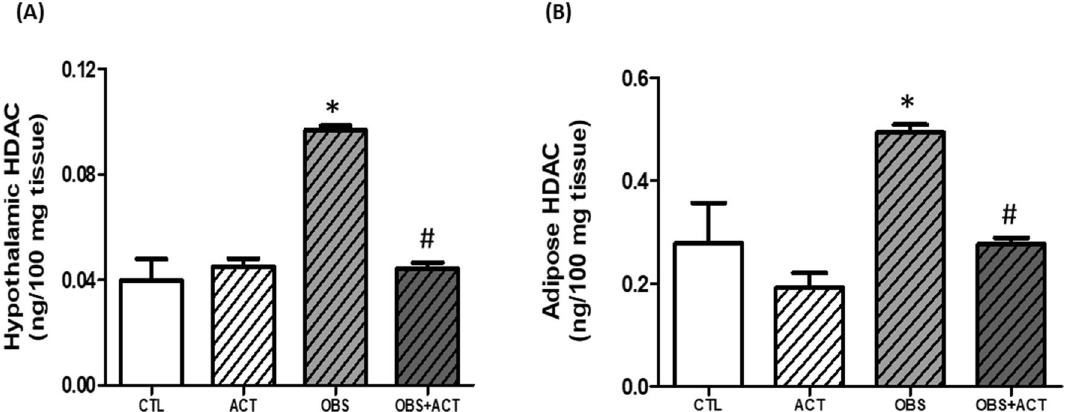
Figure 10. Effects of acetate on hypothalamic and adipose histone deacetylase ( A , B ) in high fat diet- induced obese Wistar rats. Hypothalamic and adipose HDAC, which were restored by the administration of acetate. Data are expressed as mean ± SD. n = 6 and analyzed by one-way ANOVA followed by Bonferroni post hoc test. (* p < 0.05 vs. CTL; # p < 0.05 vs. OBS). CTL Control, OBS Obesity, ACT Acetate, HDAC Histone deacetylase.